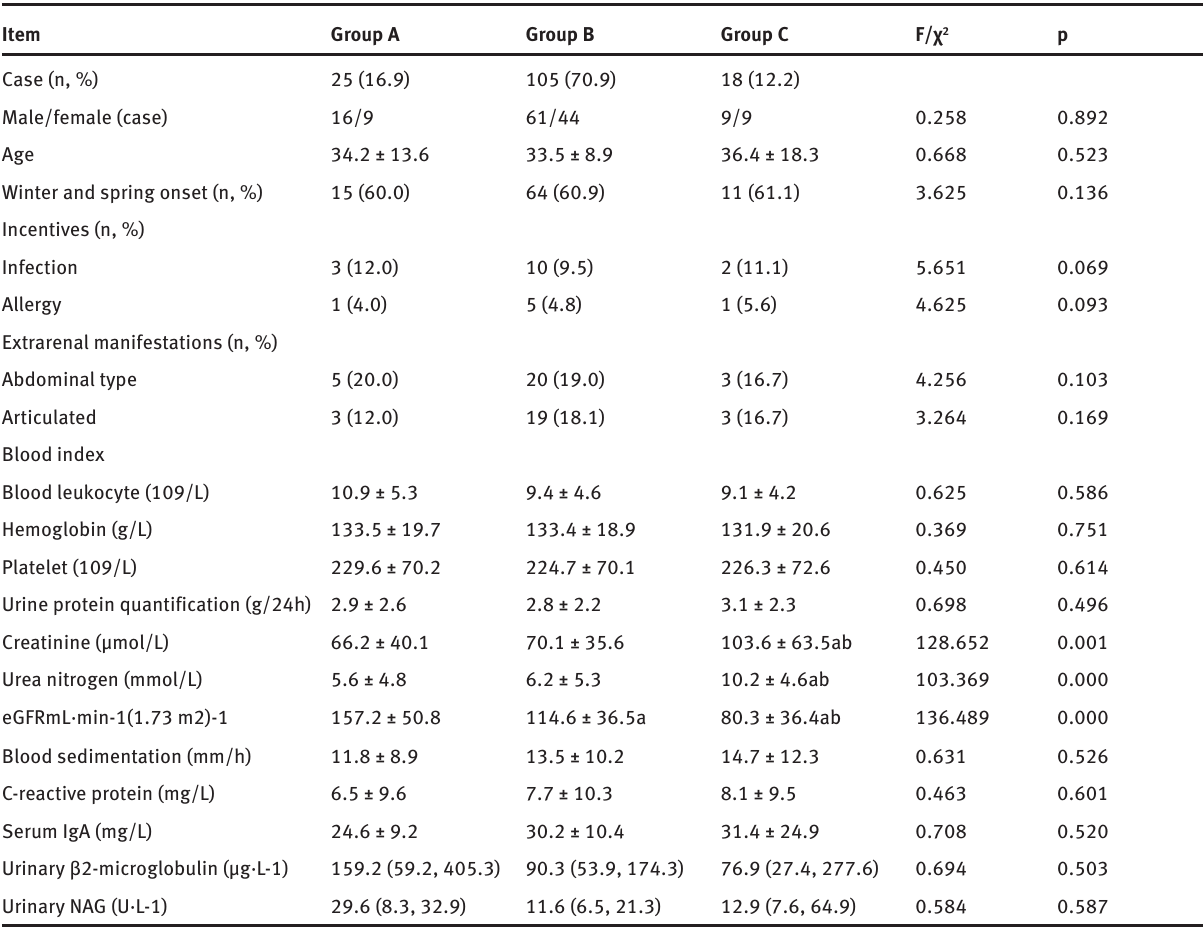
Table 1: Comparison of general data of each